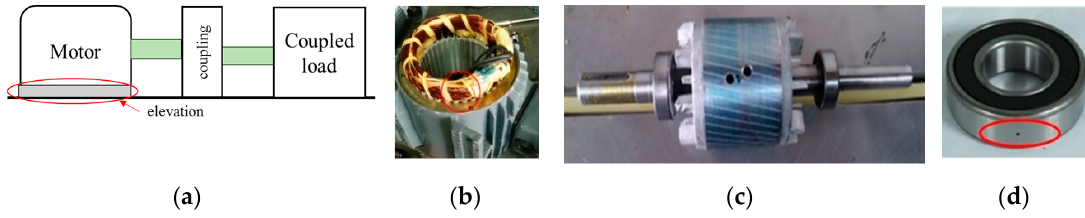
Figure 1. Four synthetically prepared motor fault conditions: ( a ) bearing axis misalignment; ( b ) stator inter-turn short circuiting; ( c ) broken rotor strip; and ( d ) outer ring bearing damage.